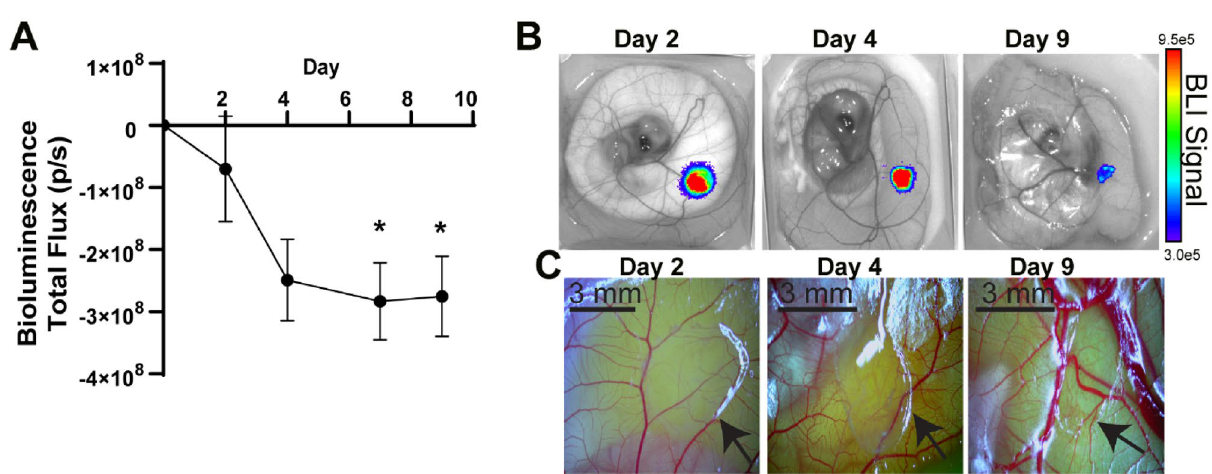
Figure 4. Engineered MCF10Aluc spheroids growth profile on the chick embryo chorioallantoic membrane (CAM). ( A ) Tumor spheroid growth curve of engineered MCF10Aluc spheroid on CAM post engrafting (5 × 10 4 cells/spheroid N = 4). Error bar represents SEM, asterisk denotes significance, Tukey’s test. ( B ) Representative image of MCF10Aluc spheroid on CAM measured via IVIS. ( C ) Representative image of MCF10Aluc spheroid on CAM observed via light